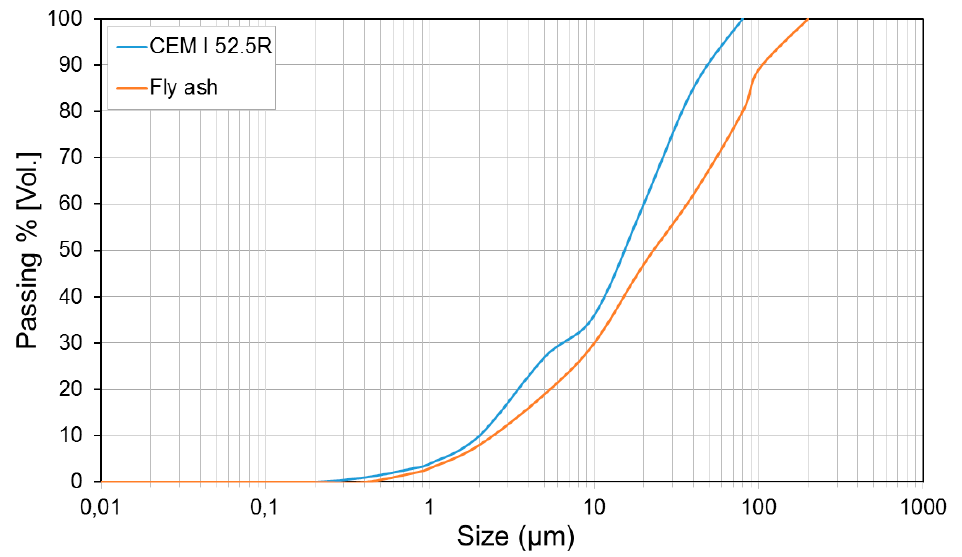
Figure 1. Particle size distributions of the fine materials used. Table 2. Mix compositions of foamed